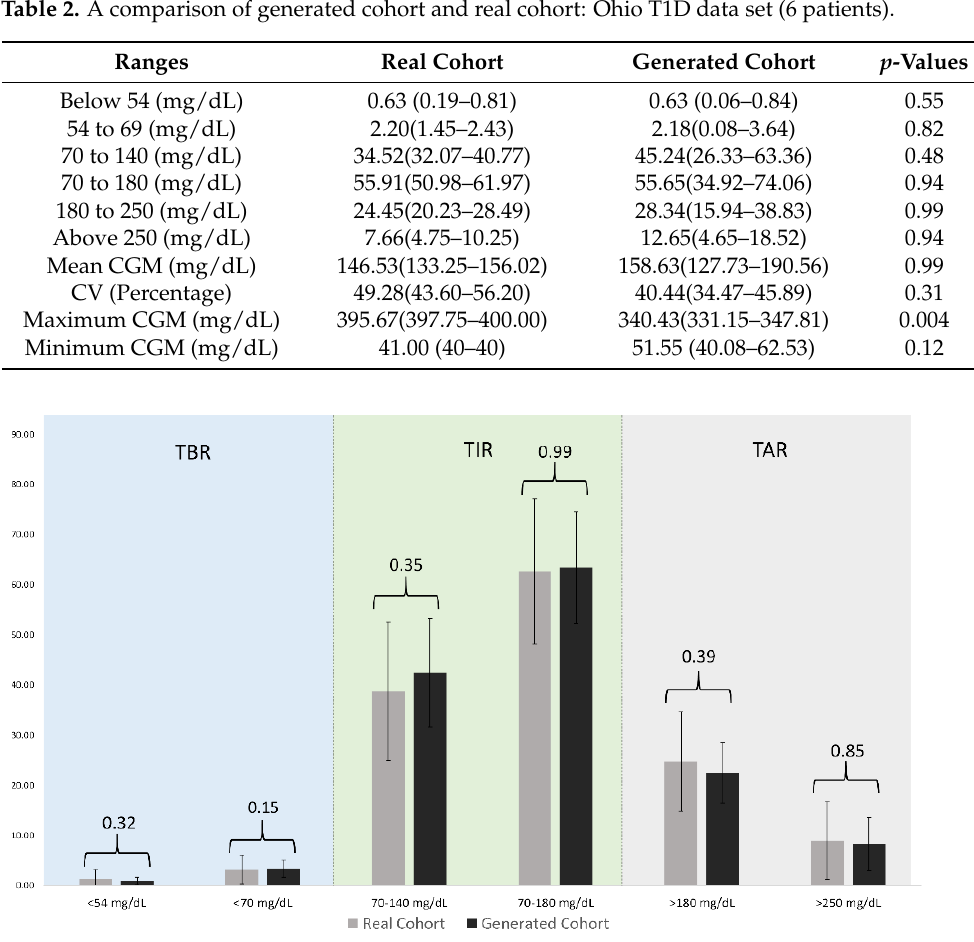
Figure 8. Times in standardized ranges of blood glucose for real and generated cohorts with corre- sponding p -values of the Midtronic’s MiniMed 640G 29 patient data set.